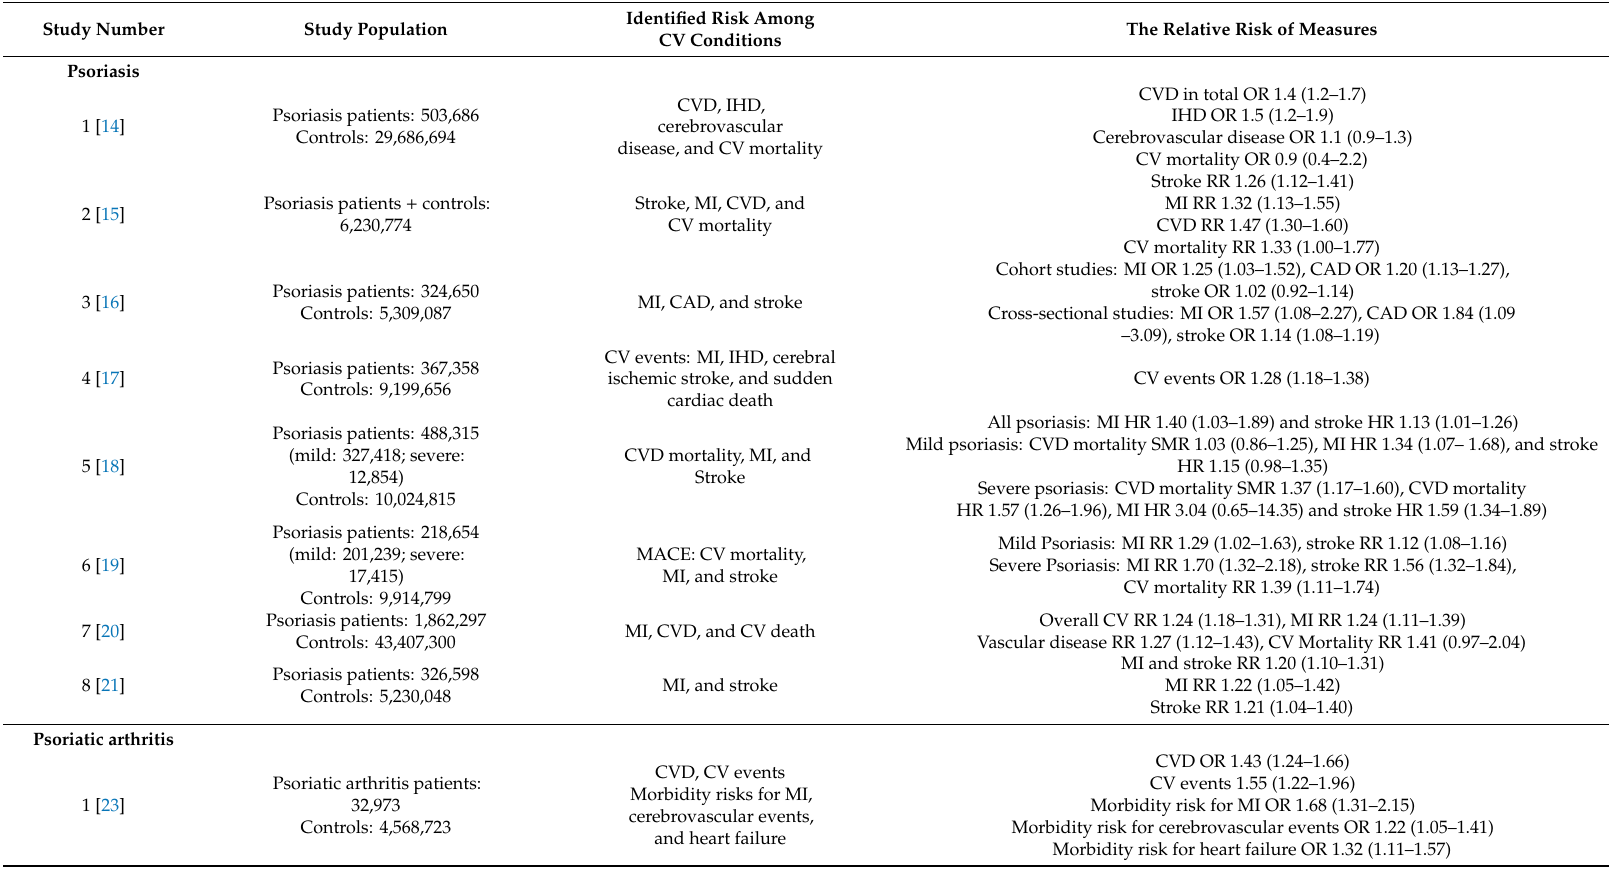
Table 1. Summary of results from systematic reviews and meta-analyses evaluating the risk of cardiovascular disease in patients with psoriasis and psoriatic